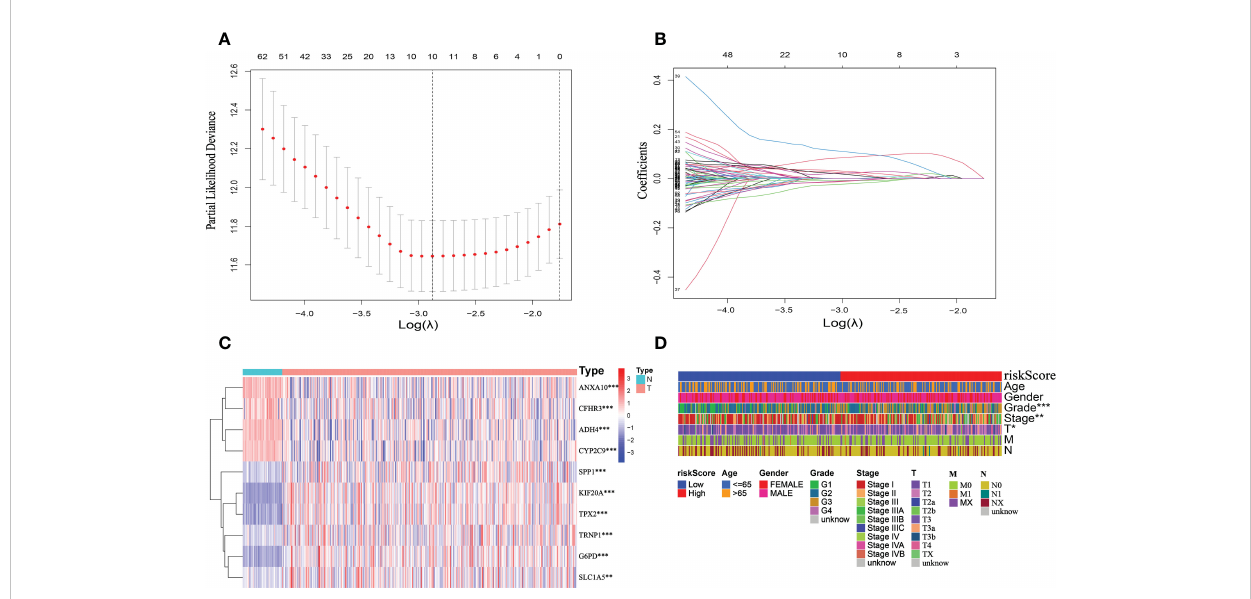
FIGURE 6 Establishment of the mitophagy-related signature according to the training set. (A, B) LASSO COX regression analysis. (C) The expression pro fi le heatmap of ten genes (*p < 0.05, **p < 0.01, ***p < 0.001). (D) Clinical relevance of high-risk and low-risk groups in TCGA cohort.